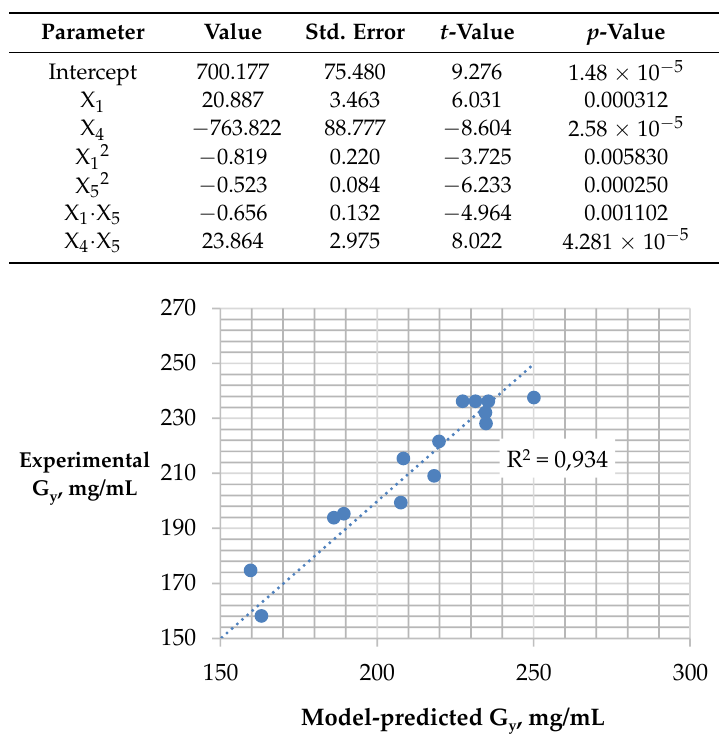
Figure 6. Analysis of variance for the theoretical (model-predicted) and experimental glucose yield for alkaline pre-treatment and enzymatic hydrolysis.